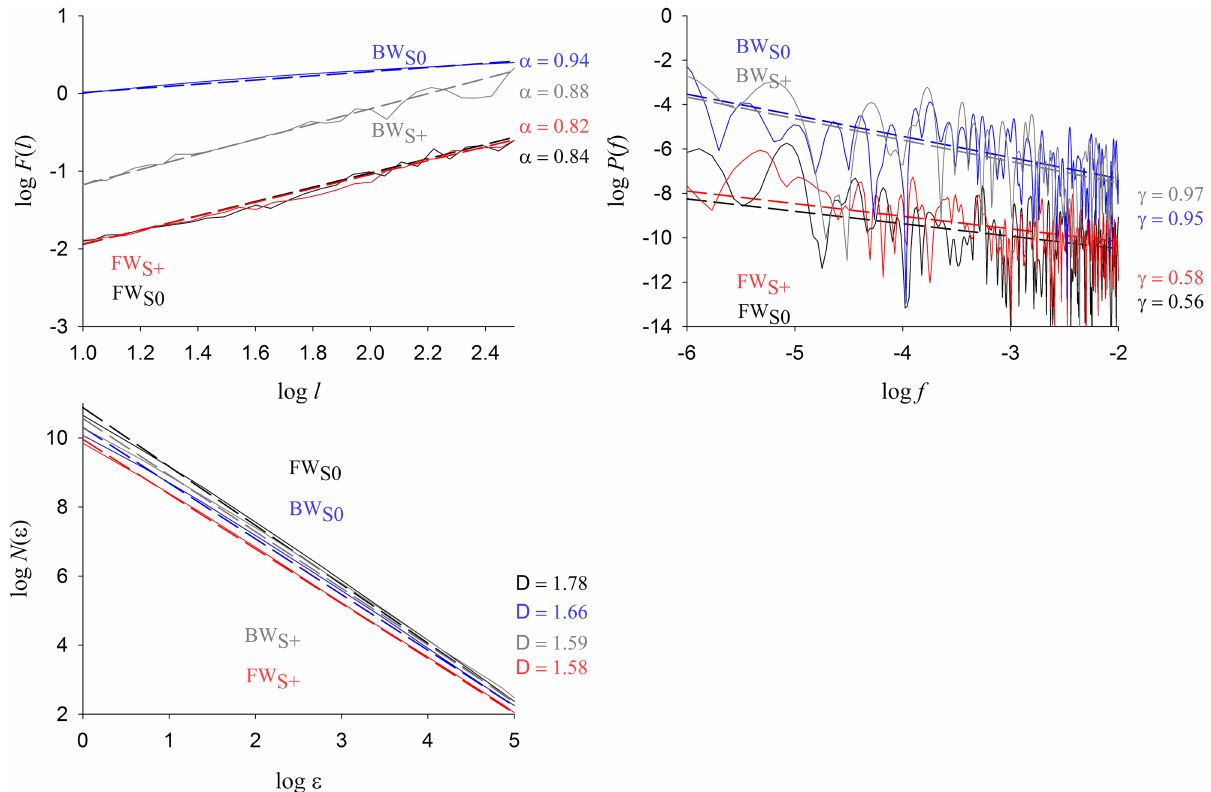
Fig 4. Typical logarithmic plots showing the linear regressions performed to find α (upper left panel), γ (upper right panel) and D (lower left panel) in the four conditions. Raw data are those of Fig